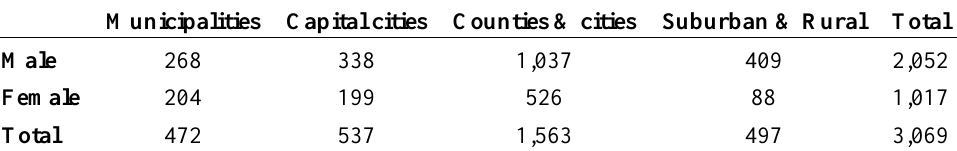
Table 1. Demographic data for